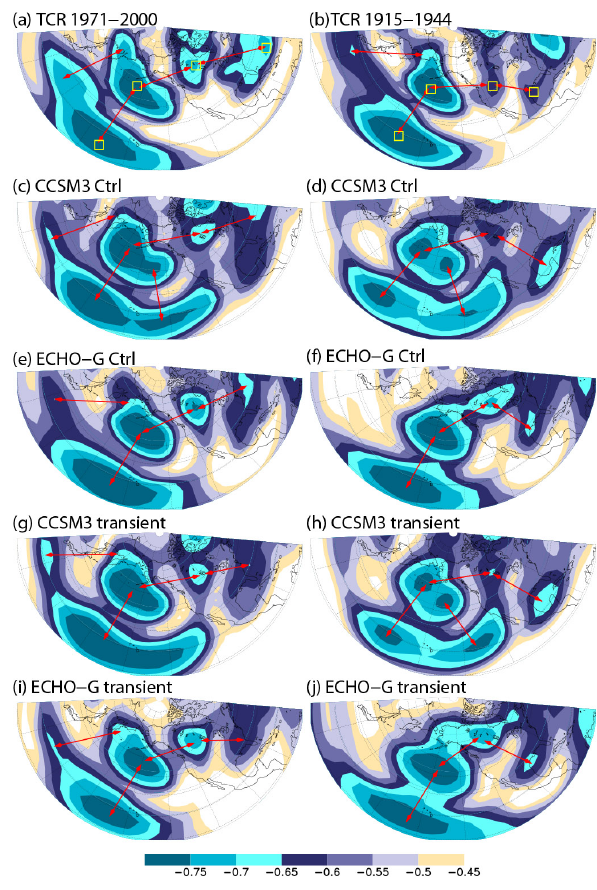
Fig. 6. Composites of teleconnectivity for all periods with high (left panels) and low (right panels) spatial correlation in the Pacific: (a) TCR for period 1971–2000, (b) TCR for period 1915–1944, (c, d) composites of all CCSM3 Ctrl simulations, (e, f) composites of the ECHO-G Ctrl1990 simulation, (g, h) composites of all CCSM3 transient simulations and (i, j) composites of all ECHO-G transient simulations. Note that the composites are selected according to a distance of at least two standard deviations from the mean of the corresponding spatial correlation times series of Fig. 4. The yellow squares in (a) and (b) show the location for the index definition in Sect.